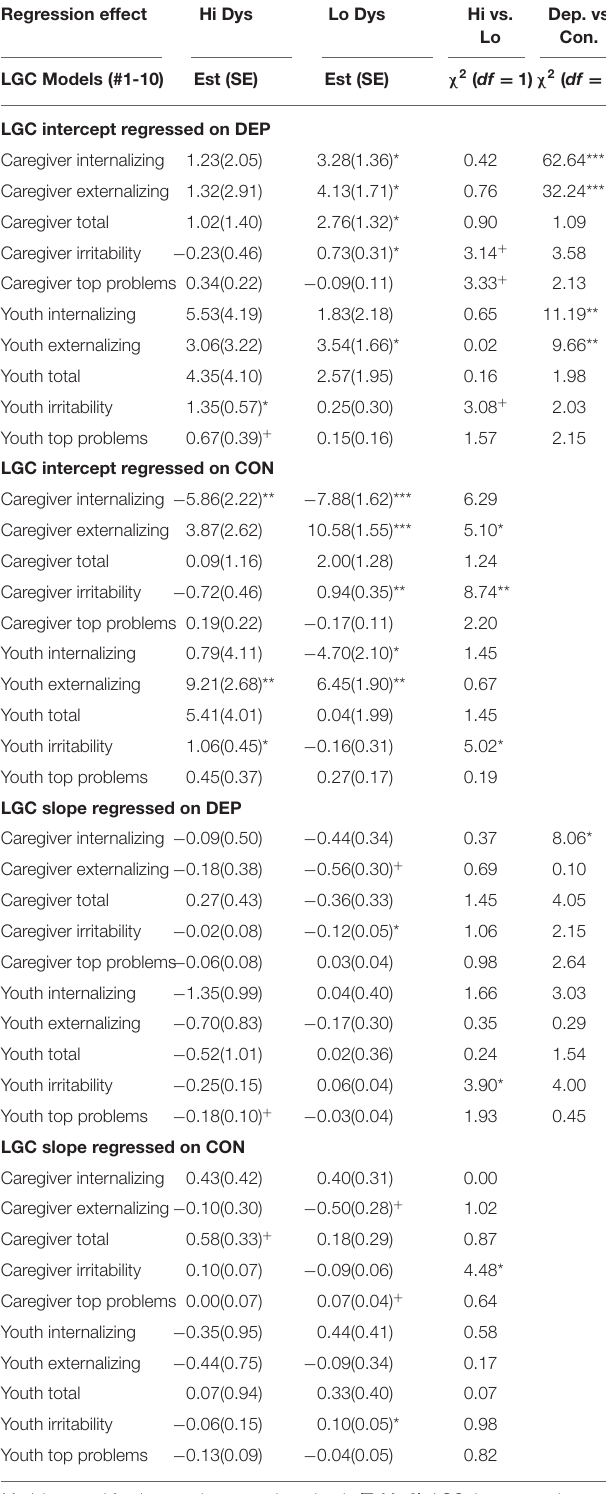
TABLE 3 | Effects of DEP and CON problem/protocol area on LGC interprets and slopes. Regression